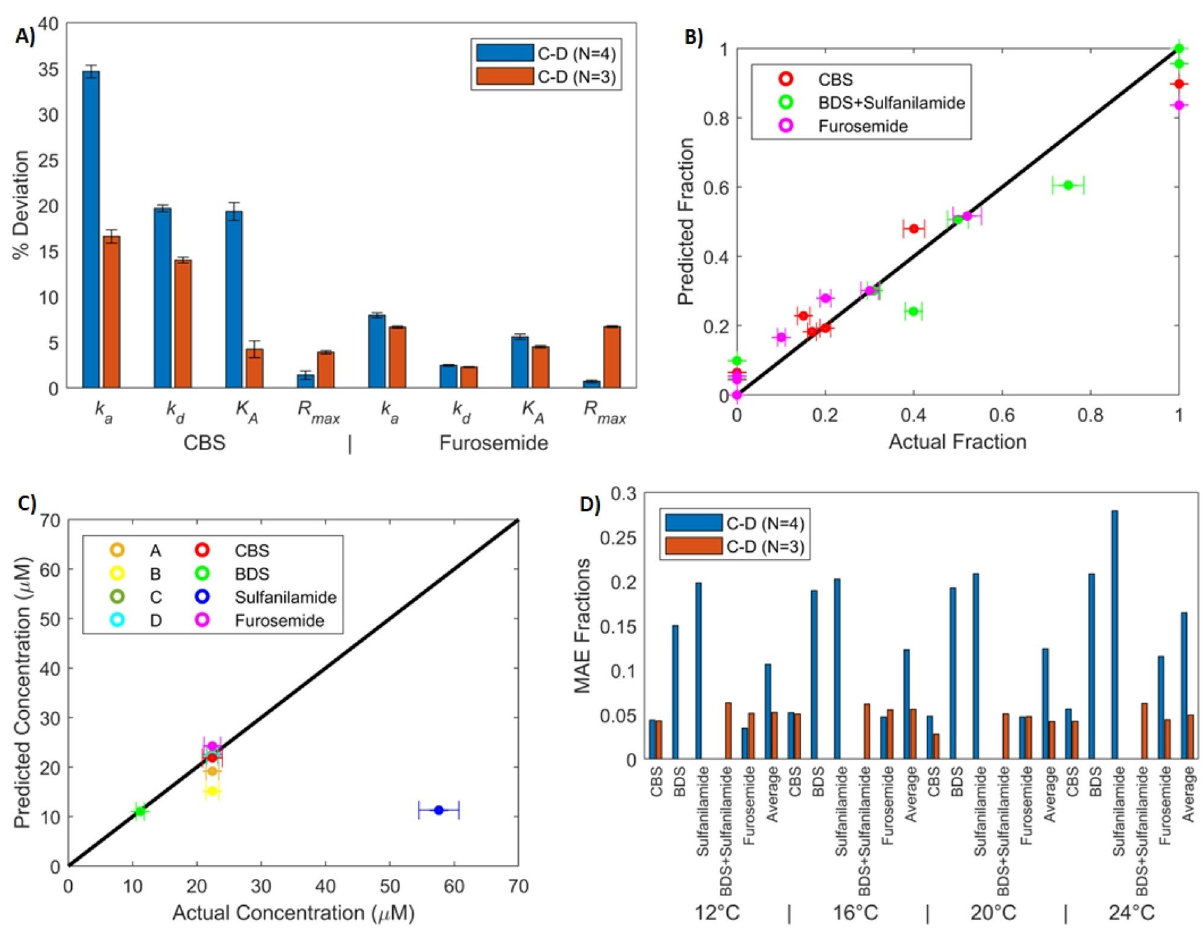
Figure 10. Performance of the kinetics identification and composition and concentration estimation algorithms when pooling BDS and sulfanilamide. ( A ) Deviation between the parameters ( k a , k d , K A and R max ) identified from single-analyte experiments and parameters identified by fitting the multi-analyte model at four temperatures with data set (C–D) for CBS and furosemide. For these fits, the total concentration and fractions of all analytes are assumed to be known (with F pool = F BDS + F sulfanilamide ). Deviations were averaged over all temperatures. Error bars were computed by propagating the standard error of the parameters identified from single-analyte and multi-analyte experiments. ( B ) Calculated fractions with respect to actual fractions of the three analytes in each of the 8 mixtures. These fractions were estimated from sensorgrams at 12 °C only. ( C ) Calculated concentration with respect to actual concentration for each of the 8 mixtures. These were estimated along the fractions using sensorgrams at 12 °C only. ( D ) Mean absolute error of estimated fractions for each analyte at each temperature. The composition estimation algorithm was used independently with pooling of BDS and sulfanilamide and without pooling. Averages over all 8 mixtures are